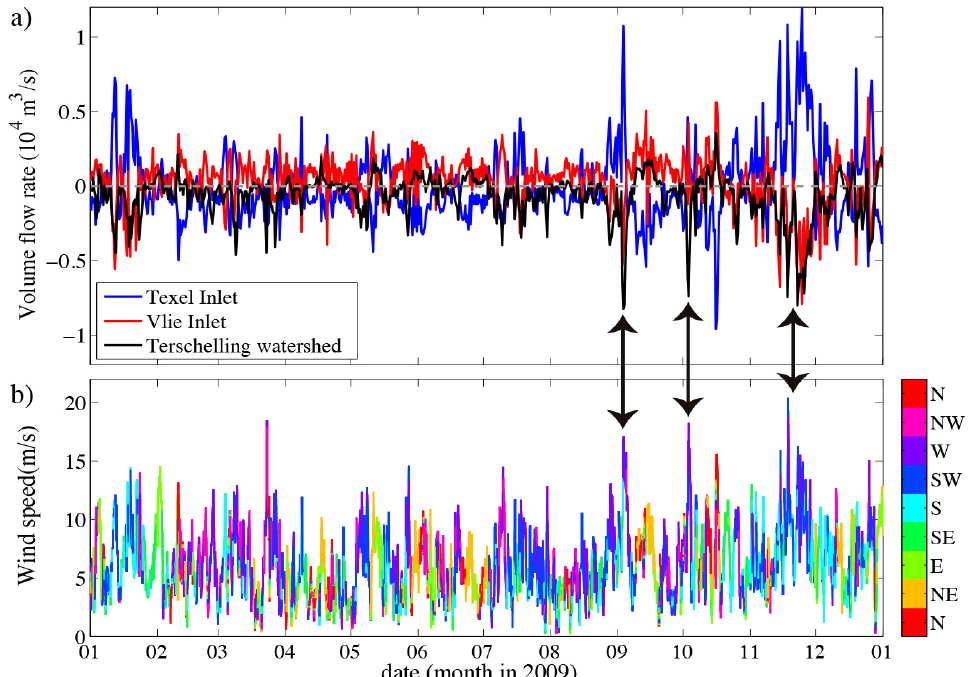
Figure 13. (a) Residual volume flow rate as a function of time for the Texel Inlet, the Vlie Inlet, and the watershed in 2009. Positive flow rate corresponds to an inflow, while negative flow rate corresponds to an outflow. (b) Wind speed and direction next to the Texel Inlet as a function of time. The wind velocity is obtained from the data used for the atmospheric forcing. The black arrows point to strong southwesterly to westerly wind events which correspond to periods when the residual circulation is inverted with respect to the typical case.